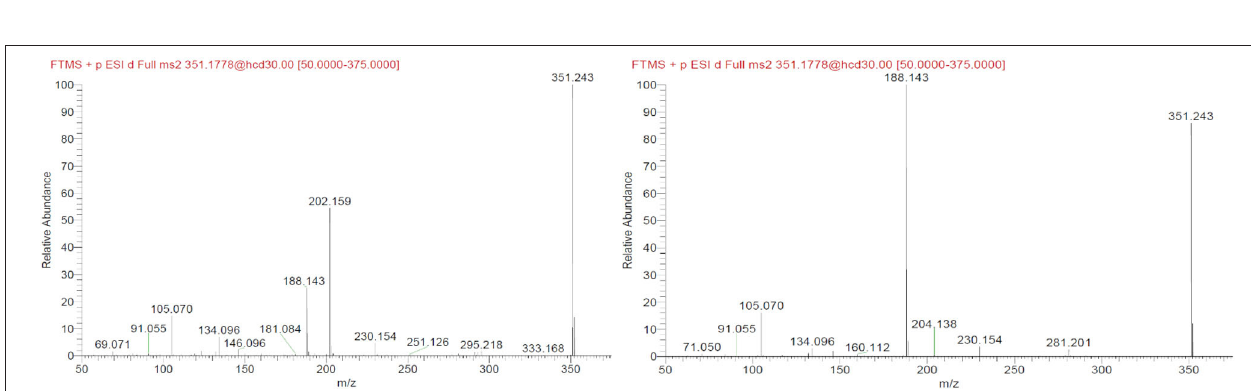
Frontiers in Chemistry |